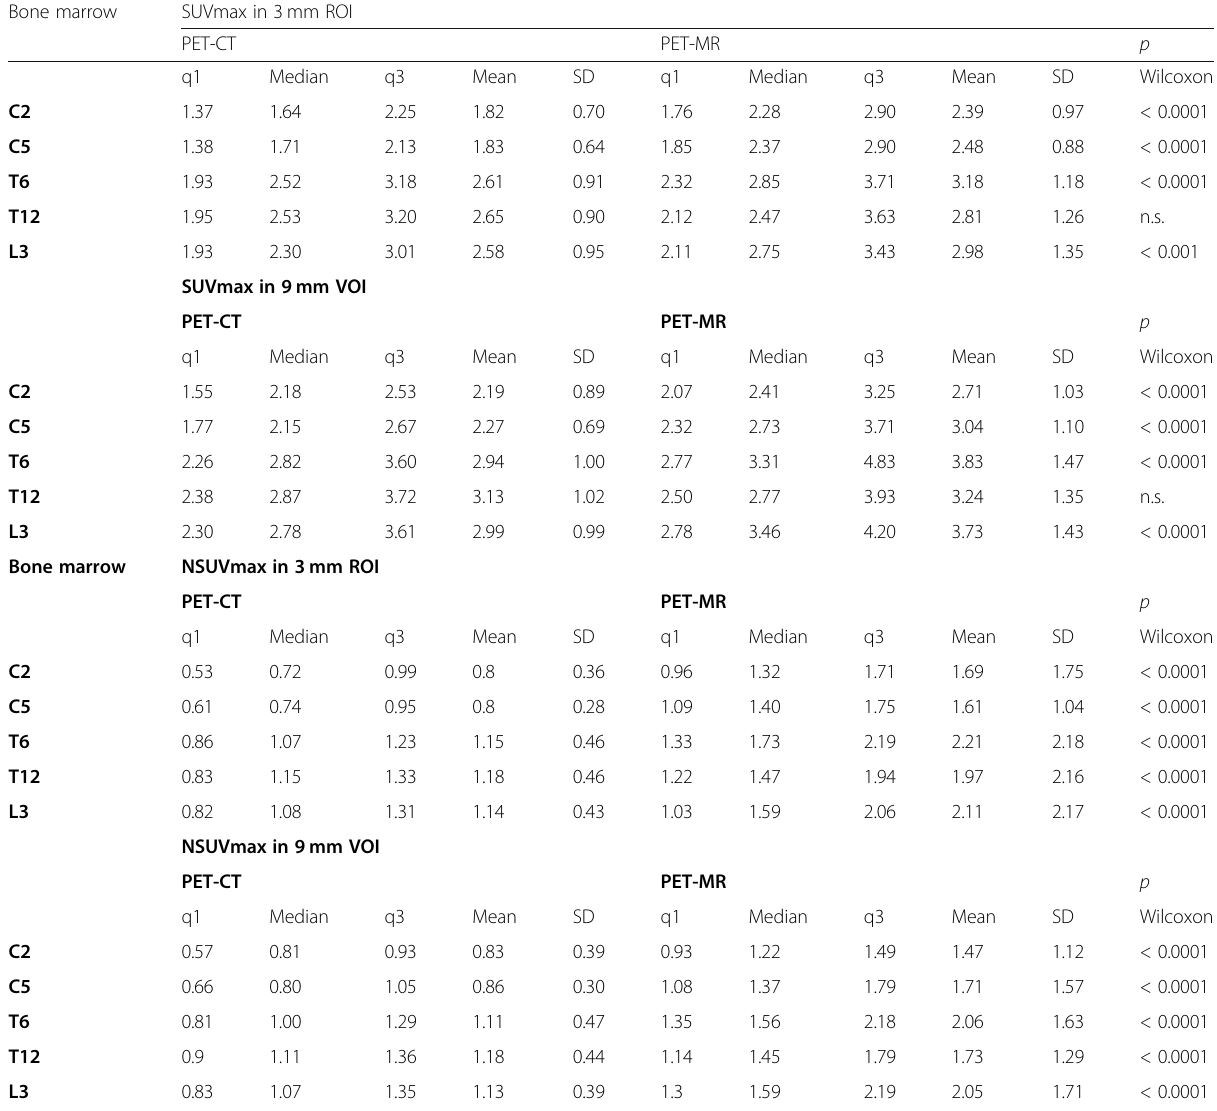
Table 2 Median, 1st and 3rd quartile of SUVmax and NSUVmax values measured in the bone marrow in both PET-CT and PET-MR, with 3 mm ROI and 9 mm VOI Bone marrow